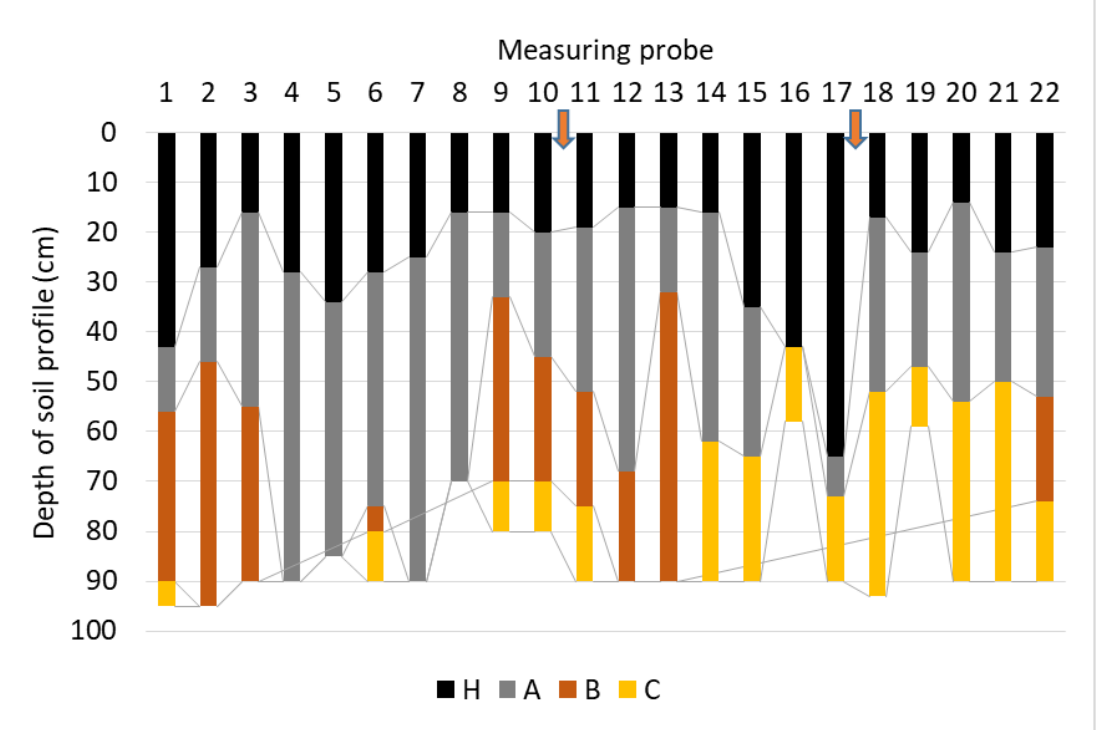
Figure 3. Soil profile horizons of the measuring probes (1 to 22; from lower to higher altitudes, see Figure 1) in the year of installation (1992). H — humified organic layer, A, B, C — mineral horizons. Arrows depict placement of the drainage ditches in 1995.